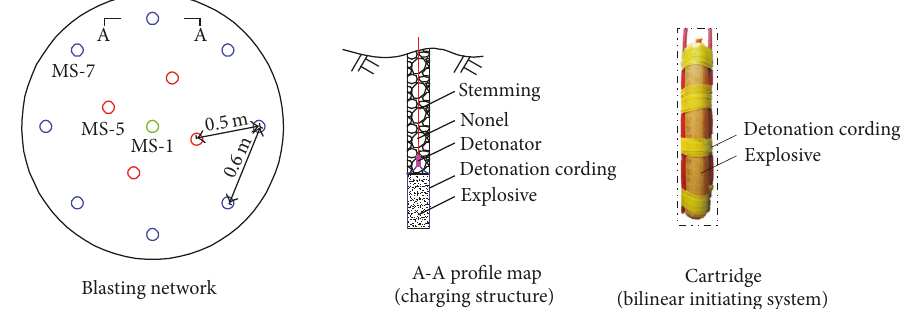
Figure 8: Blasting network and cartridge.